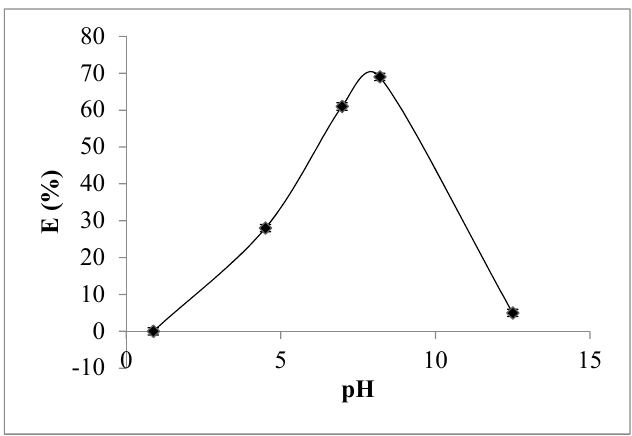
Figure 3. Equilibrium extraction of As(V) by Aliquat-336. Aqueous phase: [As(V)] = 60 ppm, flow-rate: 0.47 mL/s. Organic phase: [Aliquat-336] = 30% ( v / v ) + Kerosene + 4% ( v / v ) octanol; flow-rate: 1.4 mL/s; Membrane: PVDF hollow fiber, T = 25 °C. ∆ P = 0.3 bar.